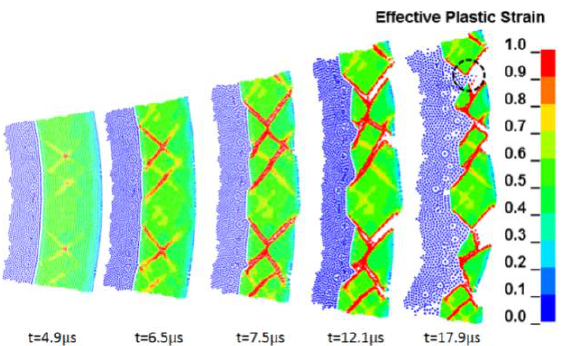
Figure 5. The evolution process of pure shear fracture under JOB9003 loading obtained by numerical simulation.